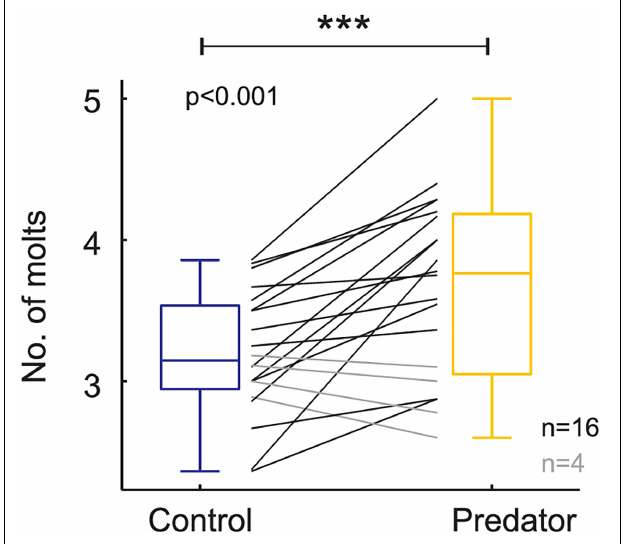
FIGURE 3 | Number of molting events based on raw data (i.e., each black and gray line represents a family). Boxplots show the mean values on control and predator treatment. *** means high